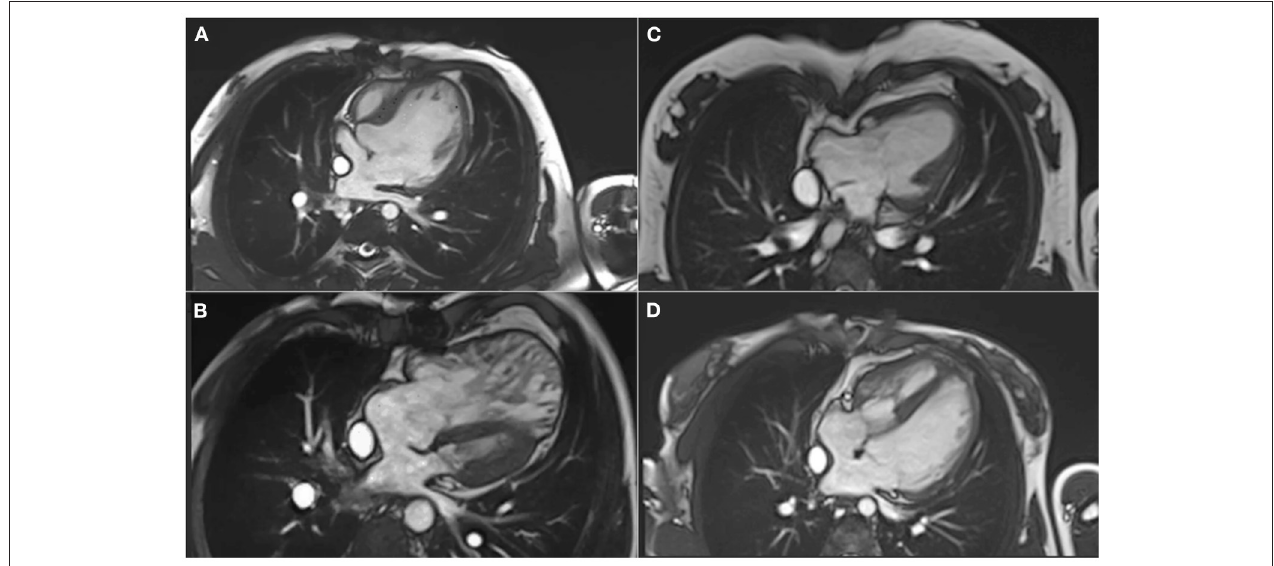
FIGURE 3 | Different types of ventricle anatomy in patients with Fontan Palliation seen by CMR (4-chamber views). (A) Tricuspid Atresia. (B) Hypoplastic Left Heart Syndrome. (C) Double Inlet Left Ventricle. (D) Pulmonary Atresia and intact Ventricular Septum with hypoplastic right ventricle.